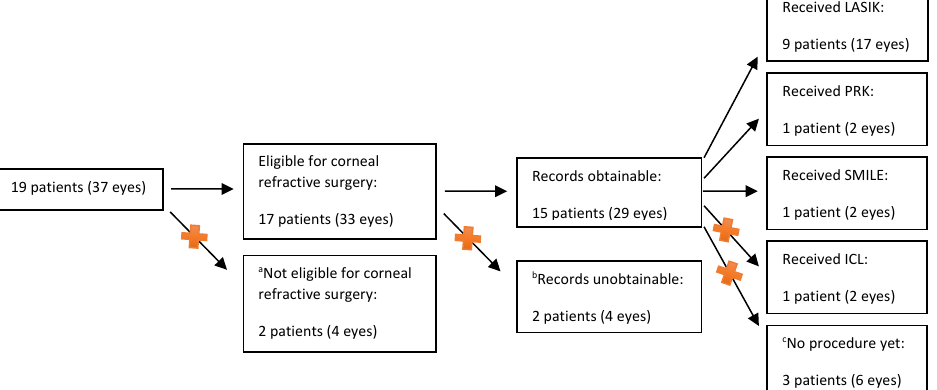
Figure 1. Patient selection flowchart. A red X indicates patients who were excluded from our data analysis. a 1 patient was ineligible due to contact lens-induced keratopathy; 1 patient was ineligible due to anterior basement membrane changes; b 2 patients were followed postoperatively by an outside provider, and they opted not to participate in this study; c 3 patients were eligible for corneal refractive surgery but have not yet scheduled the procedure due to patient